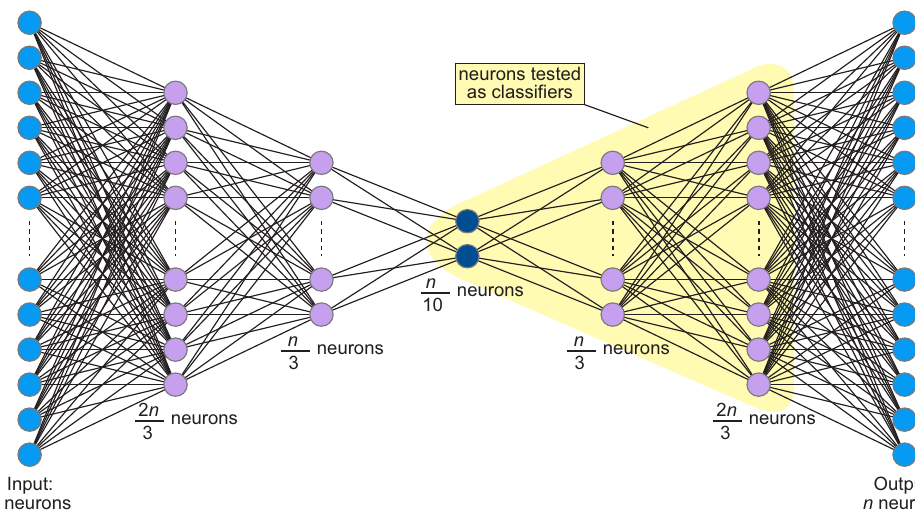
Figure 1. Network architecture. The sizes of the layers depend to the program vector dimensions. In all our experiments, we considered n = 300. Layers highlighted in yellow are those tested in the